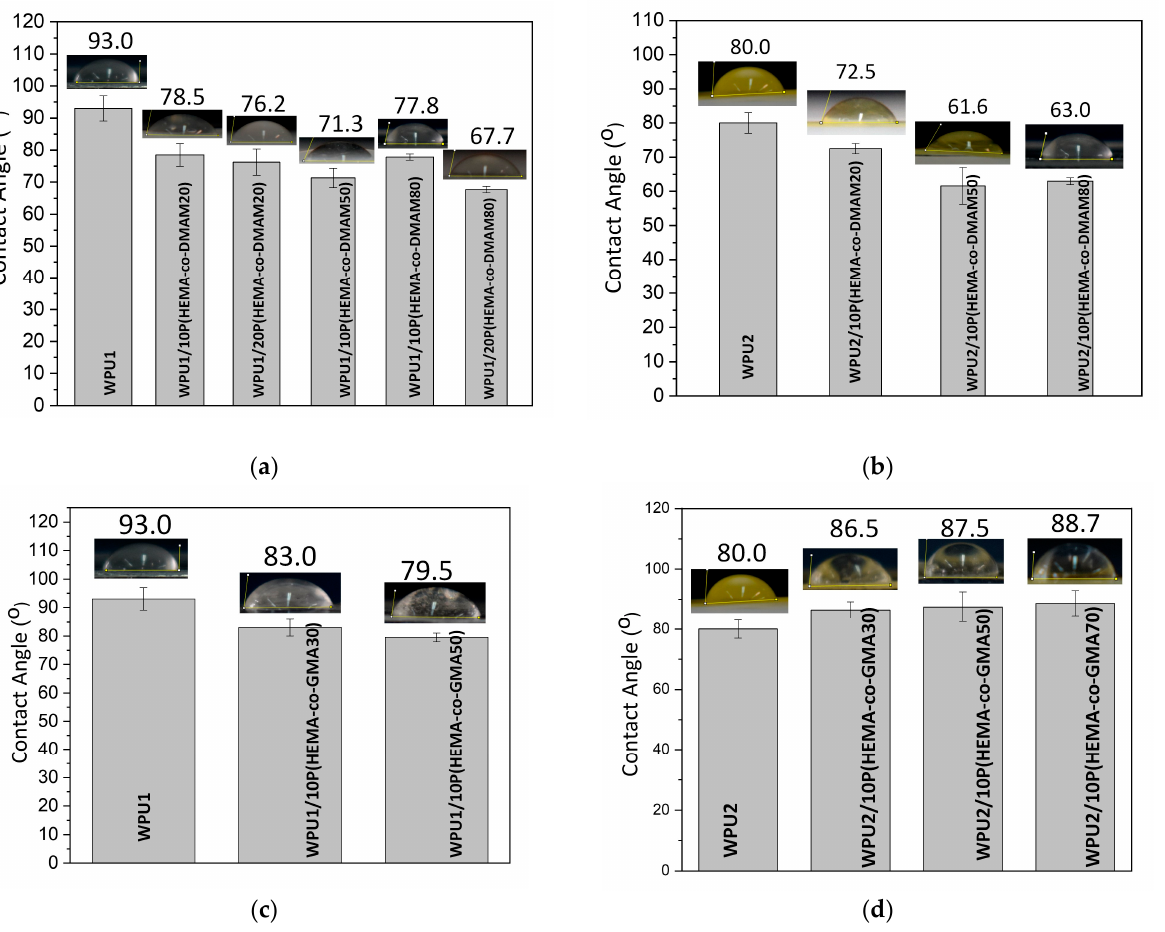
Figure 5. Water contact angles of WPU and WPU/polymer films: ( a ) WPU1/xP(HEMA-co-DMAMy); ( b ) WPU2/xP(HEMA-co-DMAMy); ( c ) WPU1/xP(HEMA-co-GMAy); ( d ) WPU2/xP(HEMA-co-GMAy).